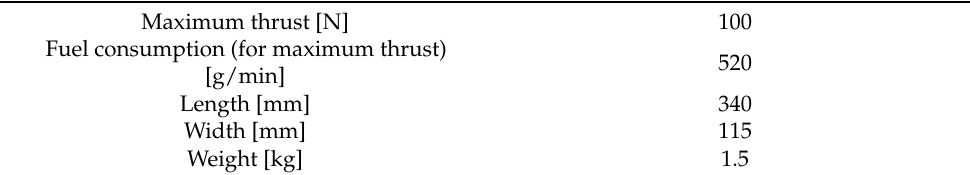
Table 4. Technical parameters of the GTM-120